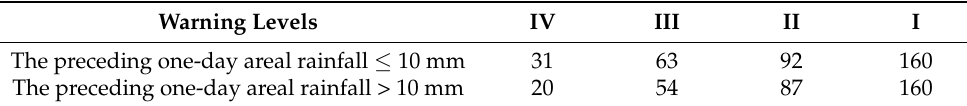
Table 3. The 1-day areal rainfall thresholds for early flood warnings (mm).